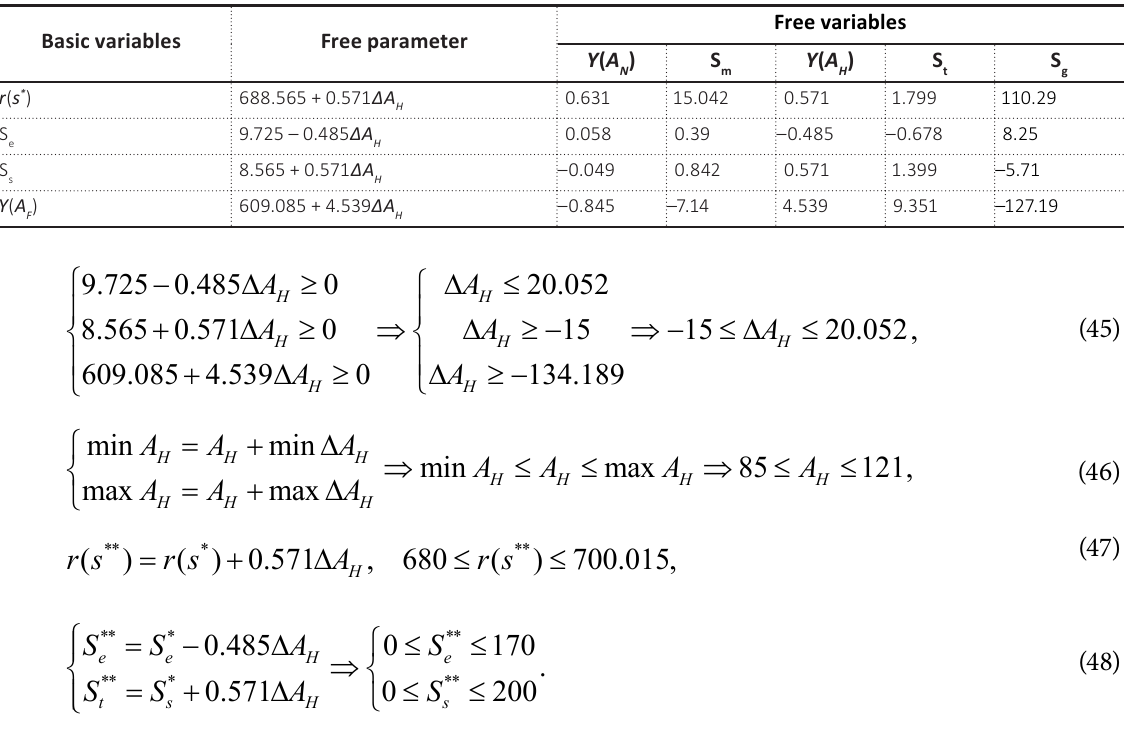
Table A9. Price variability for “wow-effect” tourism services (destination of health and medical tourism) Basic Free variables